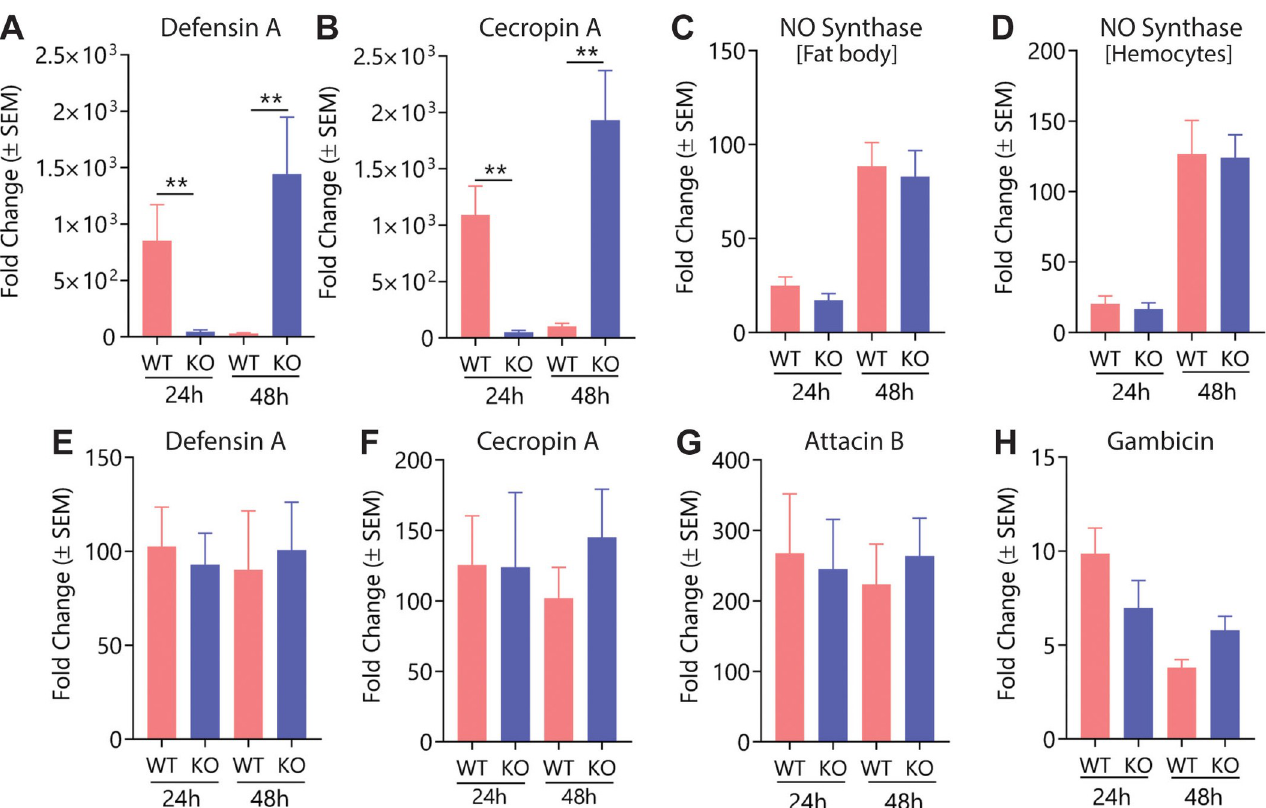
Fig 4. Effect of mJHBP deficiency on the expression of markers of immune function in hemocytes, fat body and midgut tissues. Relative expression levels for defensin A ( A ) and cecropin A ( B ) in hemocytes from E . coli -challenged WT and KO females measured at 24 and 48 h post-infection (n = 6, 3 biological replicates of 2 individuals). Relative expression levels for nitric oxide synthase (NOS) in fat body ( C ) and hemocytes ( D ) from E . coli - challenged females measured at 24 and 48 h post-infection (n = 6, 3 biological replicates of two individuals). Relative expression levels for defensin A ( E ), cecropin A ( F ), attacin B ( G ), and gambicin ( H ) in midguts from E . coli -challenged WT and KO females measured at 24 and 48 h post-infection (n = 6, 3 biological replicates of 2 individuals). Data were analyzed using the Mann-Whitney U test ( �� p � 0.01).